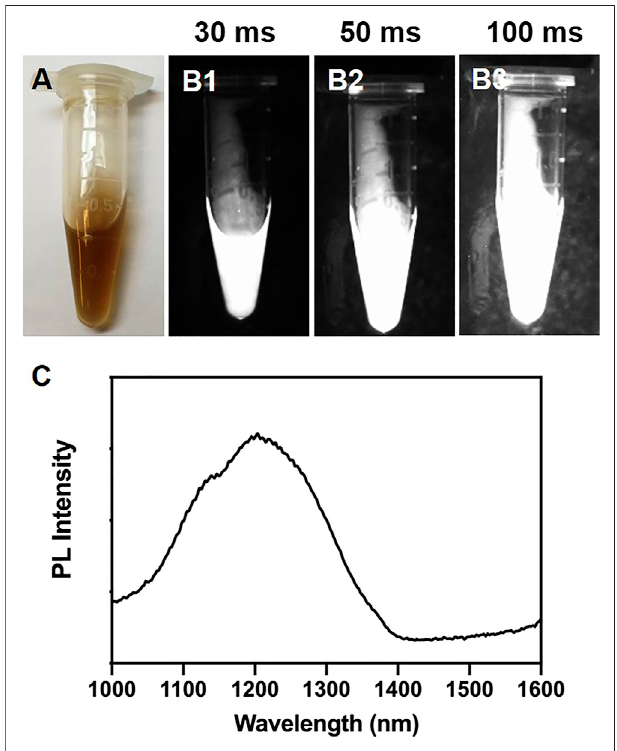
50 ms and 100 ms. (C) PL intensity of the prepared PbS